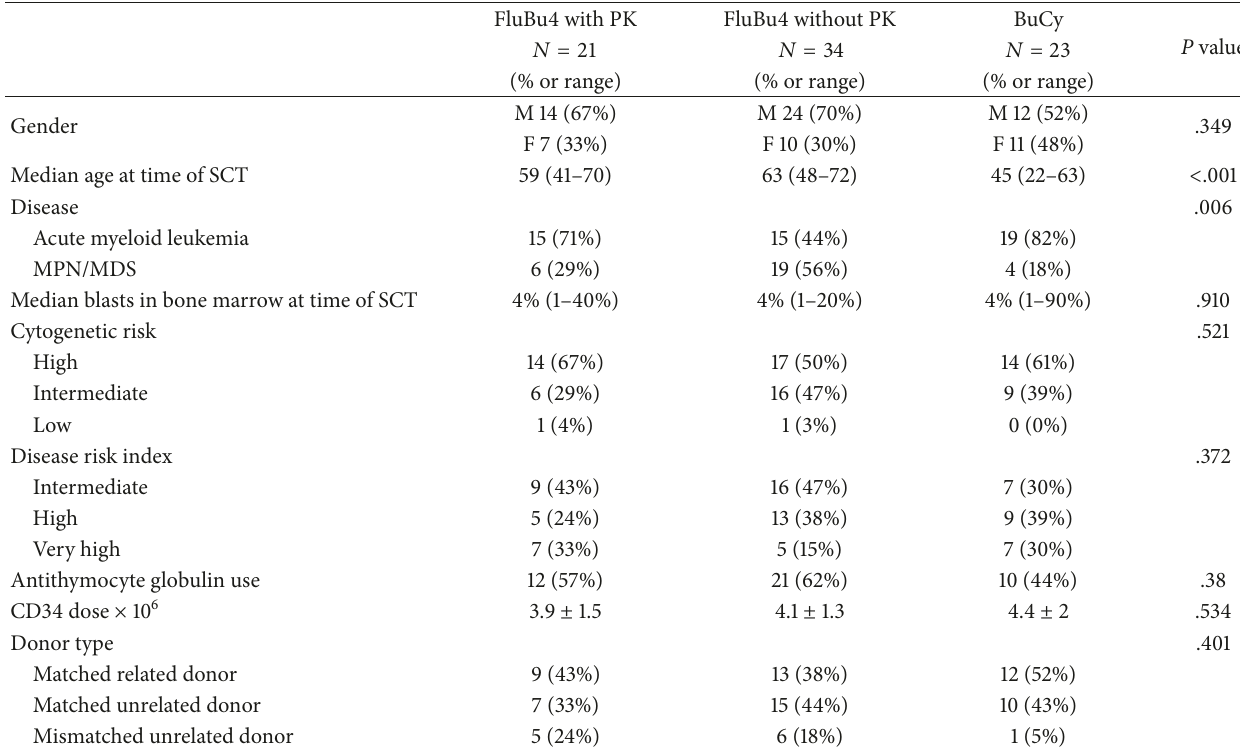
Table 1: Summary of patient characteristics by treatment group.